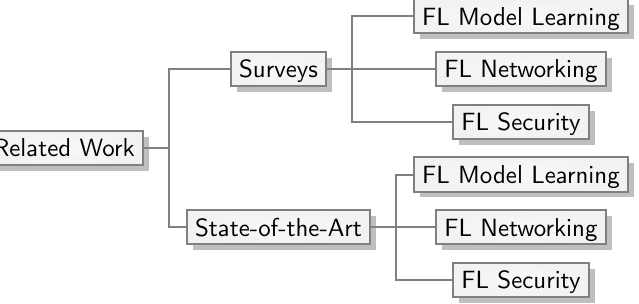
Figure 2. A functional taxonomy of related surveys and state-of-the-art